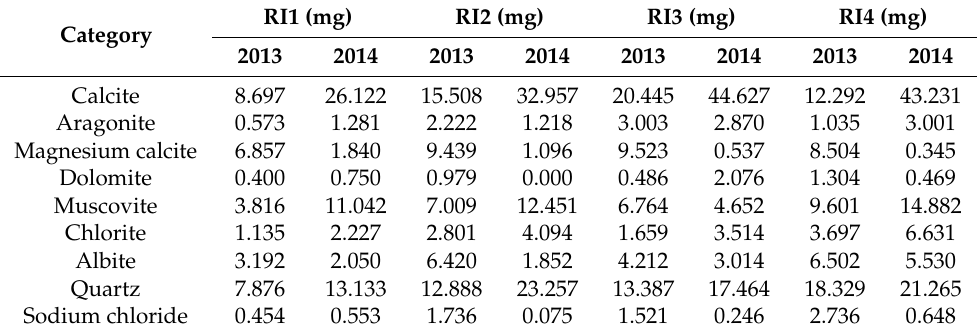
Table 5. Chemical constituents of clogging substances in the